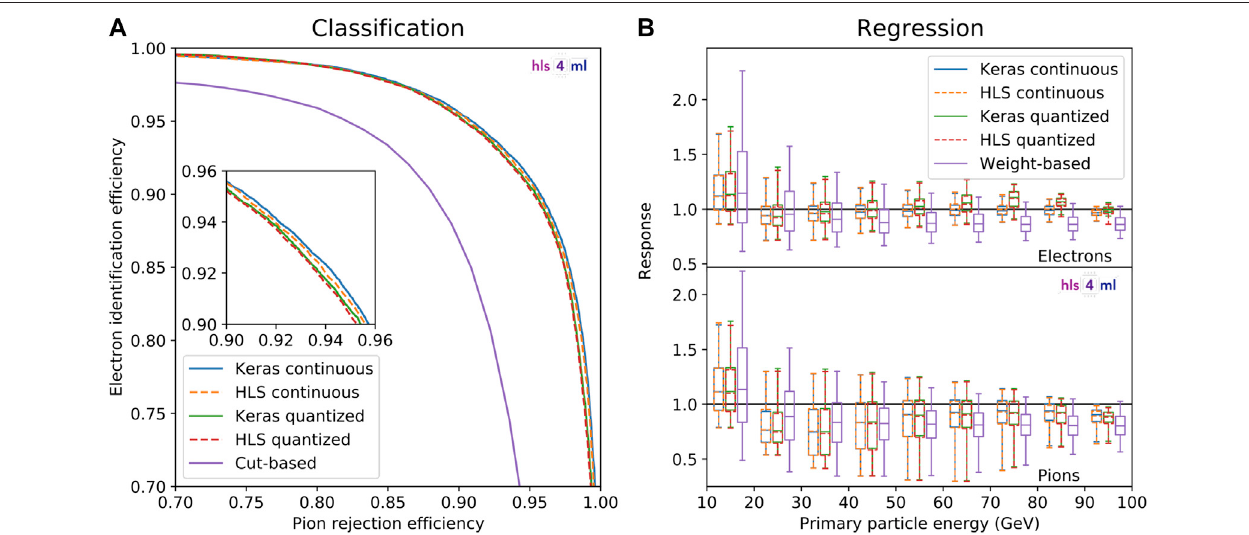
FIGURE 4 | Classi fi cation (A) and regression (B) inference performance of the continuous and quantized GARNET -based models and the reference algorithms. Results from the KERAS and HLS implementations are shown for the GARNET -based models. The classi fi cation performance is quanti fi ed with a ROC curve of electron identi fi cationef fi ciencyvs.pionrejectionef fi ciency.Theinsetin (A) showsaclose-upviewoftheef fi ciencyrange0.90 – 0.96forbothaxes.Theregressionperformanceis quanti fi edastheresponse ( E pred / E true ) in10 GeVbinsof E true .Thehorizontallineintheboxcorrespondstothemedianofthedistribution,thetopandbottomofthe box to the upper and lower quartiles, and the upper and lower ends of the whiskers to the 95th and 5th percentiles.